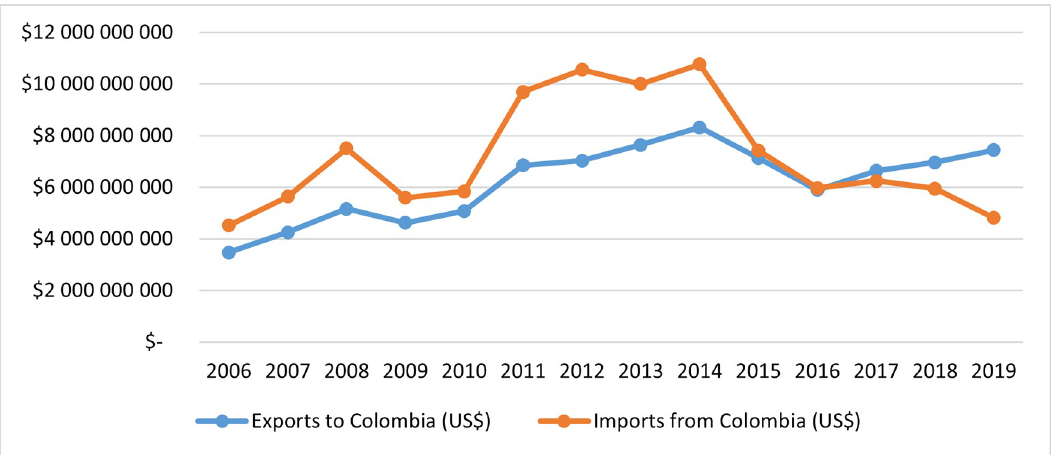
Fig 3. EU exports and imports with Colombia 2006–2019. Source: Prepared by the author, based on data from UN Comtrade database [37].